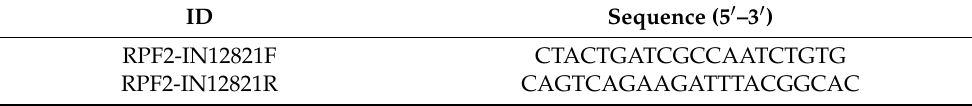
Table 4. Primer information of RPF2-IN12821.